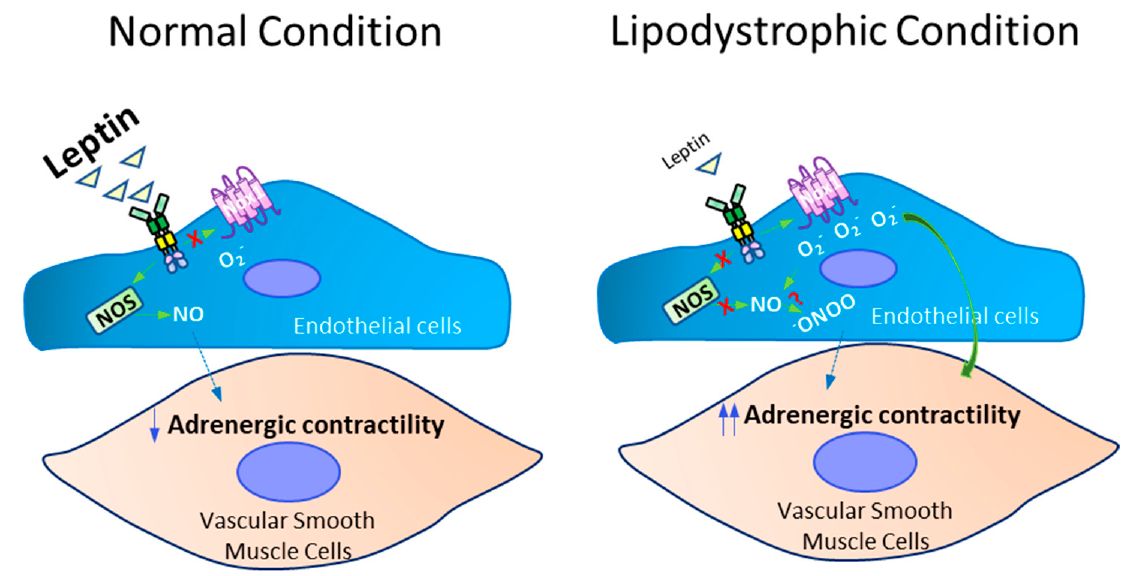
Figure 6. Reduced endothelial leptin signaling increases adrenergic vascular contractility by increasing Nox1-derived ROS. Roles of leptin on vascular adrenergic contractility in physiological and lipodystrophic conditions.